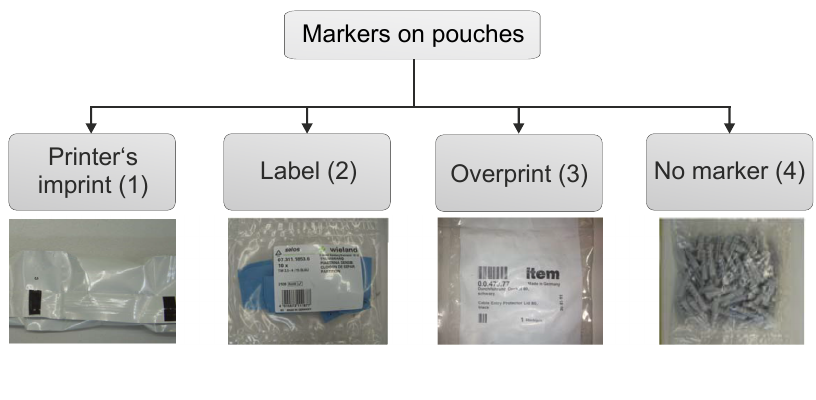
Figure 3. Systematic of possible different ways to mark a